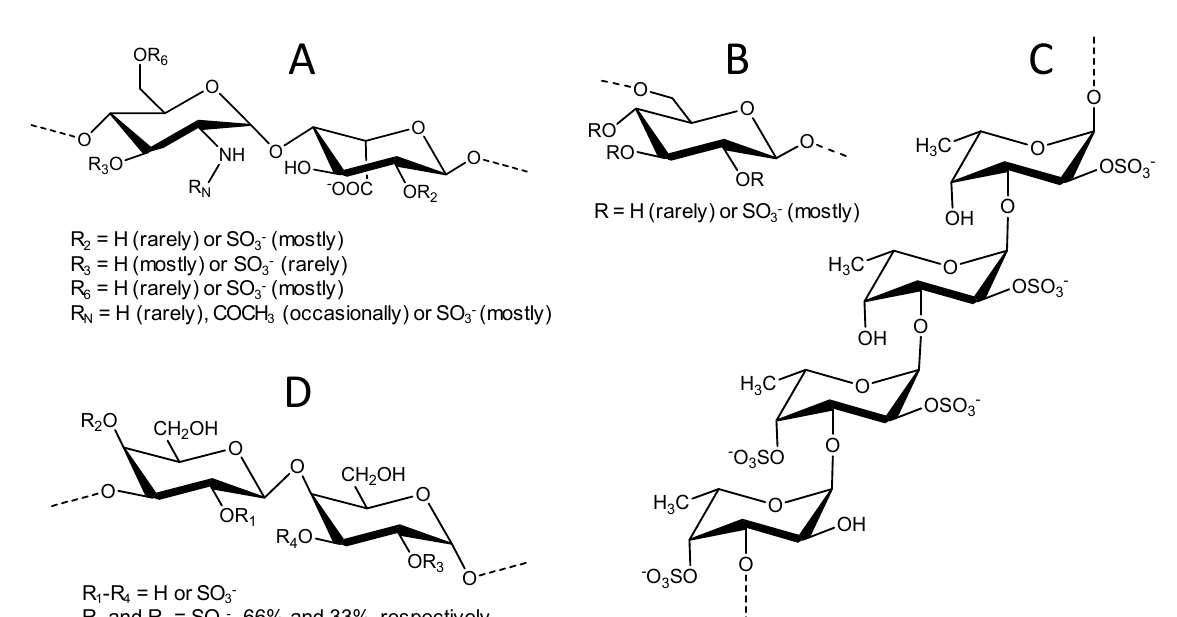
Figure 1. Structural representation of unfractionated heparin, UFH ( A ); dextran sulfate, DxS ( B ); Lytechinus variegatus sulfated fucan, LvSF ( C ); and Botryocladia occidentalis sulfated galactan, BoSG ( D ).